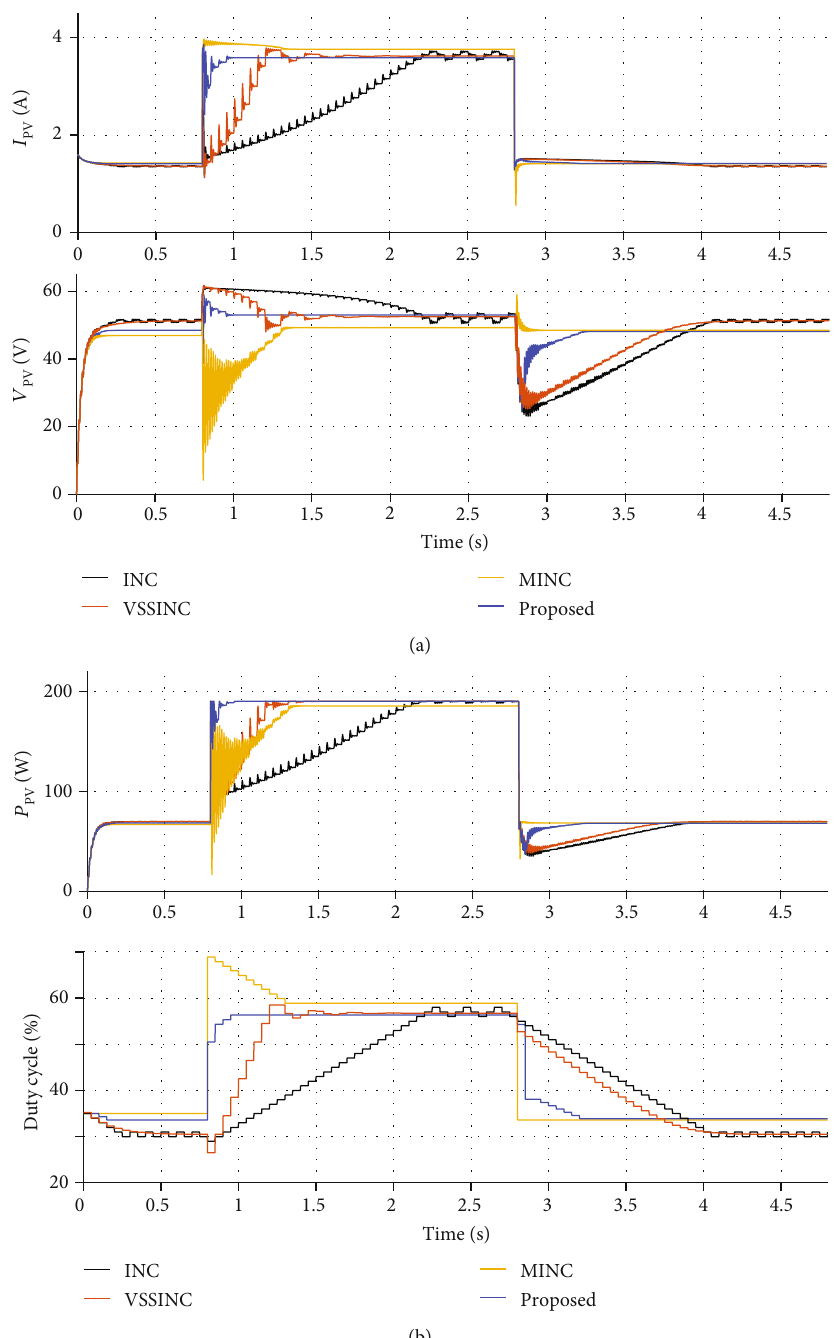
Figure 8: Simulation results of the INC, VSSINC, MINC, and the proposed technique for the irradiance variation under strong intensity: (a) current and voltage; (b) power and duty